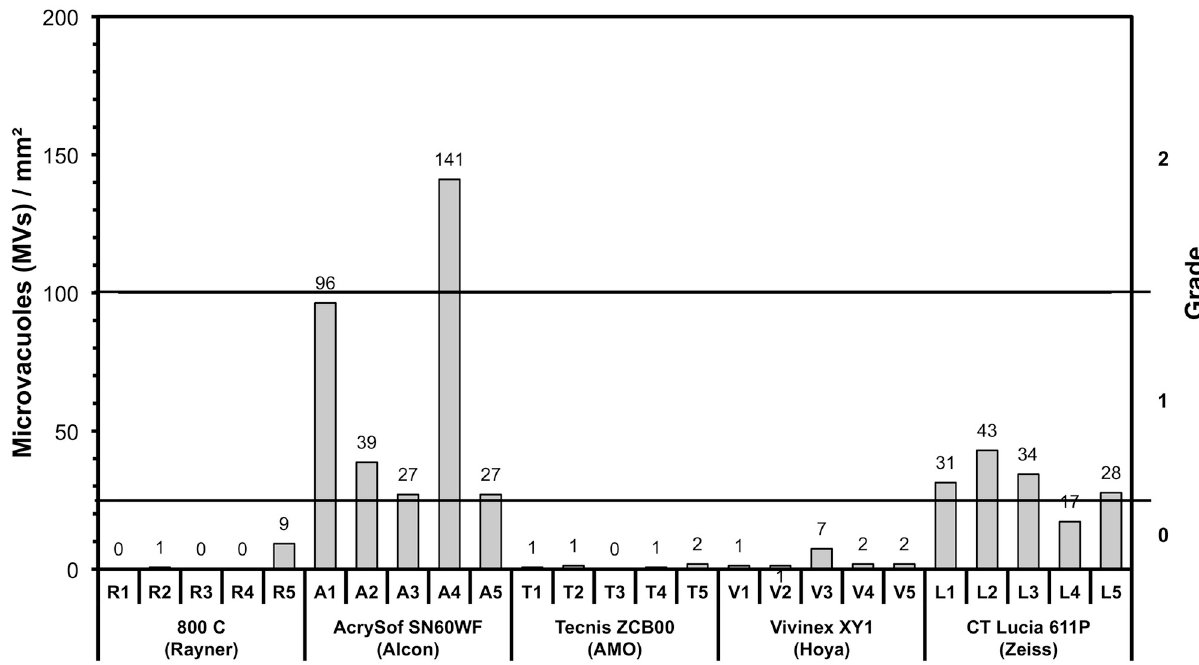
Fig 3. Number of glistenings of all tested IOLs obtained from image analysis after accelerated glistening induction. The secondary y-axis shows the relationship to the grading system. MVs/mm 2 , microvacuoles per square millimetre.